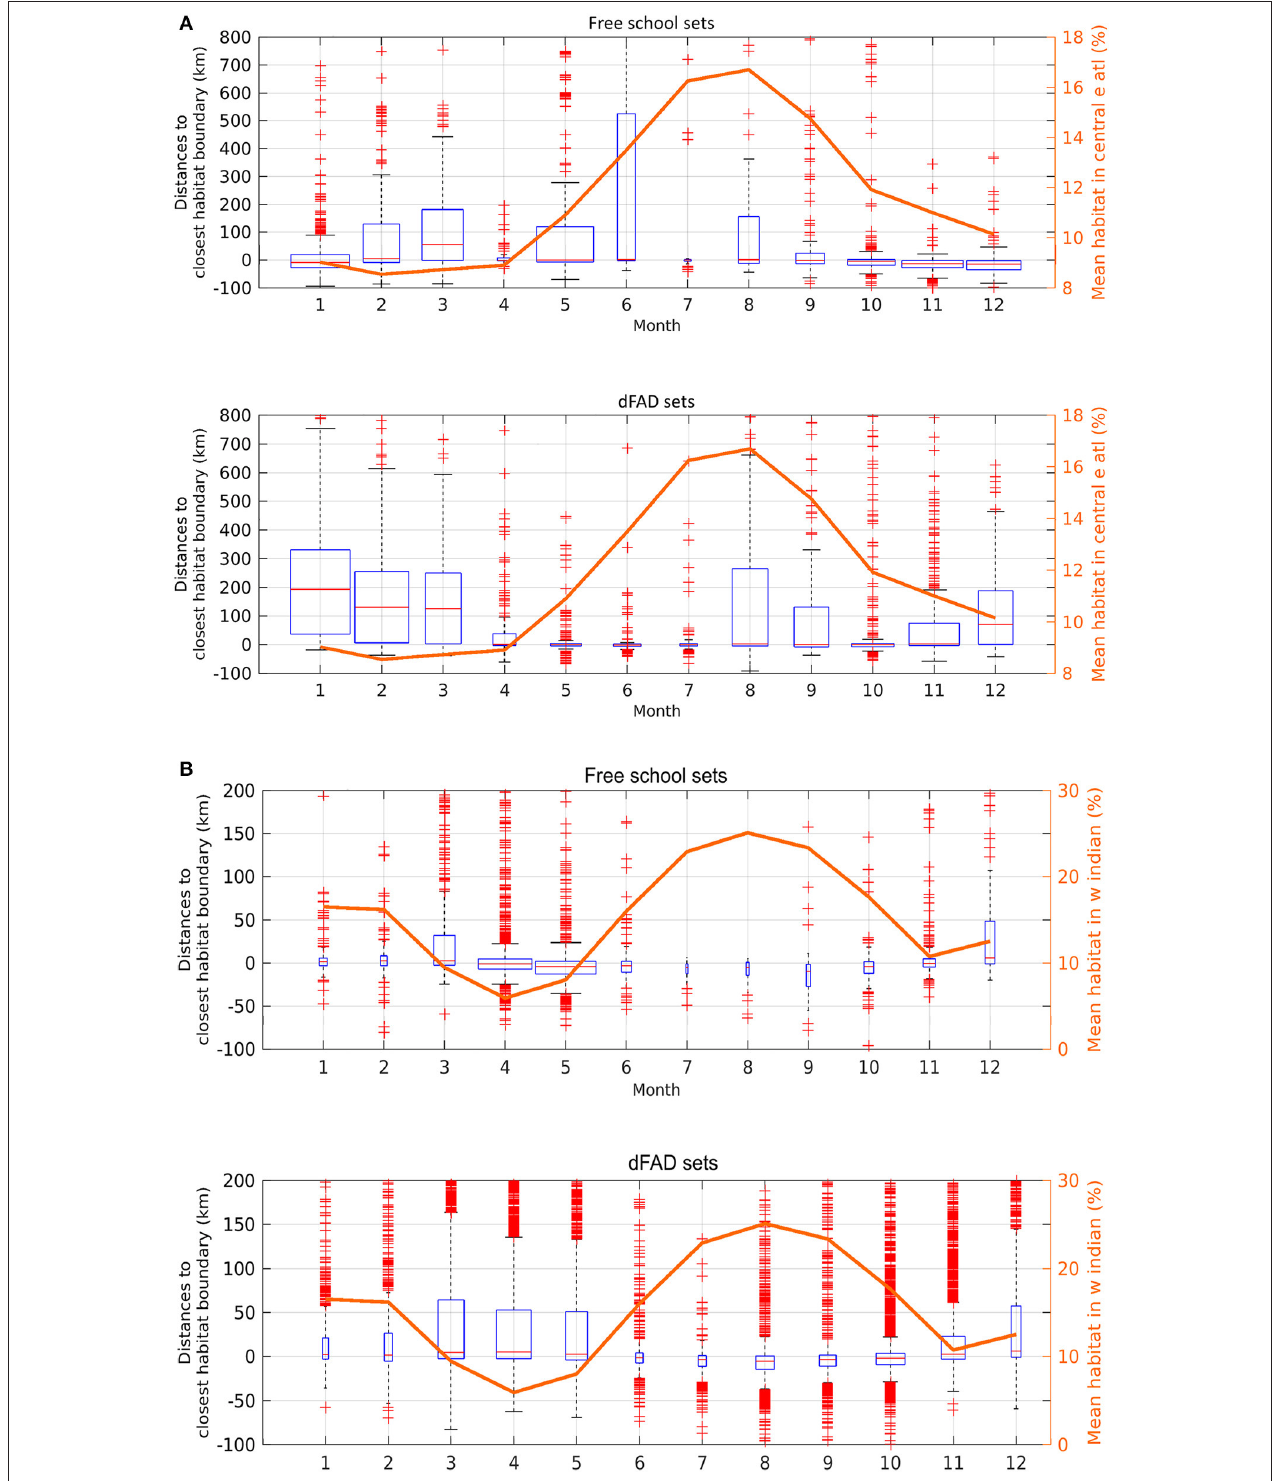
FIGURE 4 | Monthly boxplots of the distances between skipjack tuna ( Katsuwonus pelamis; SKJ) presence data and the closest favorable feeding habitat boundary for free-swimming school sets (FSC; upper panels) and drifting fish aggregating device associated sets (dFADs; lower panels) in (A) the Eastern Central Atlantic Ocean and (B) the Western Indian Ocean from 1998 to 2014. Negative values correspond to presence data points observed inside the favorable feeding habitat. The width of the boxes is proportional to the monthly number of sets while the box length corresponds to the interquartile range (median value in red, whiskers cover 99.3% of data if normally distributed, red crosses are outliers). The monthly sizes of favorable feeding habitats were overlaid (right axis, mean fraction of ocean area).